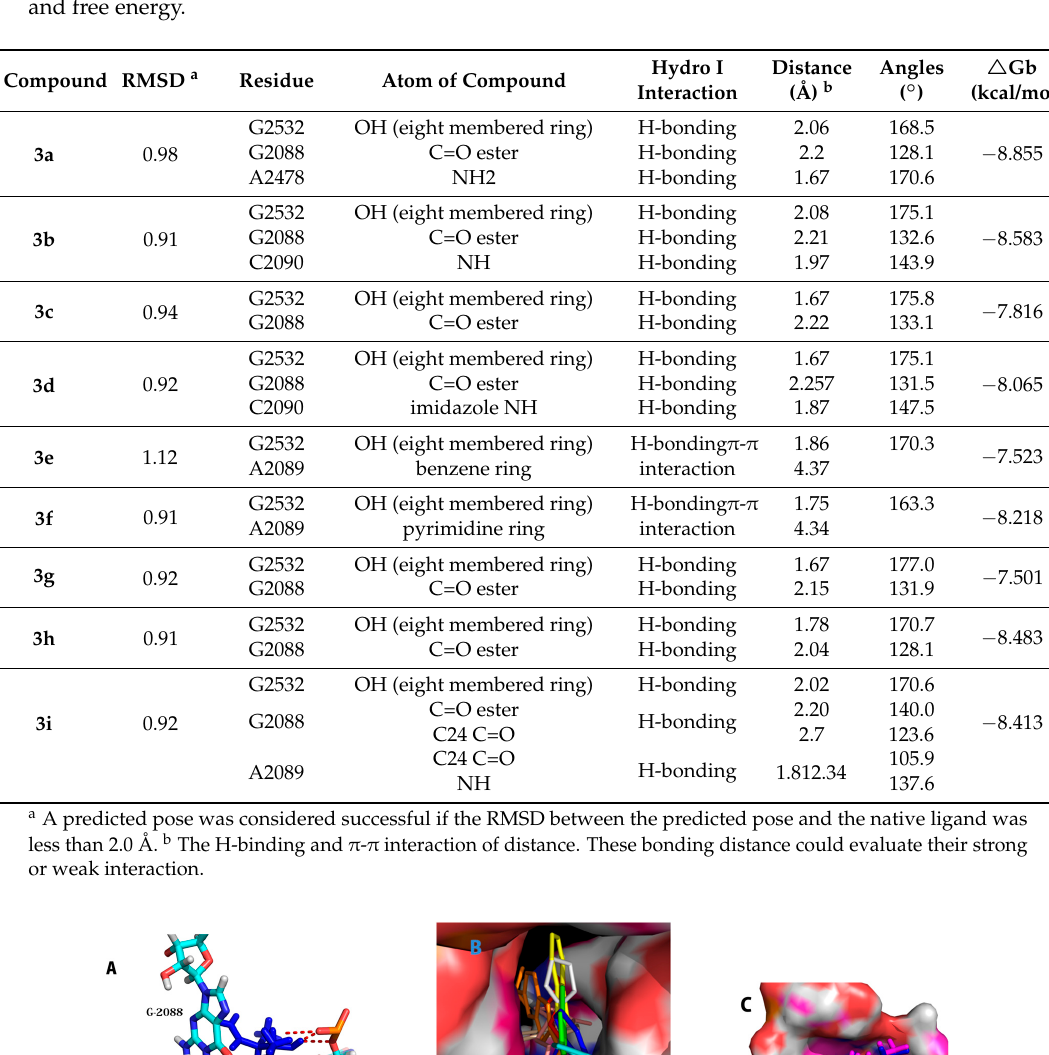
Table 2. Binding RMSD (Root-mean-square Deviation), number of noncovalent molecular interactions and free energy.